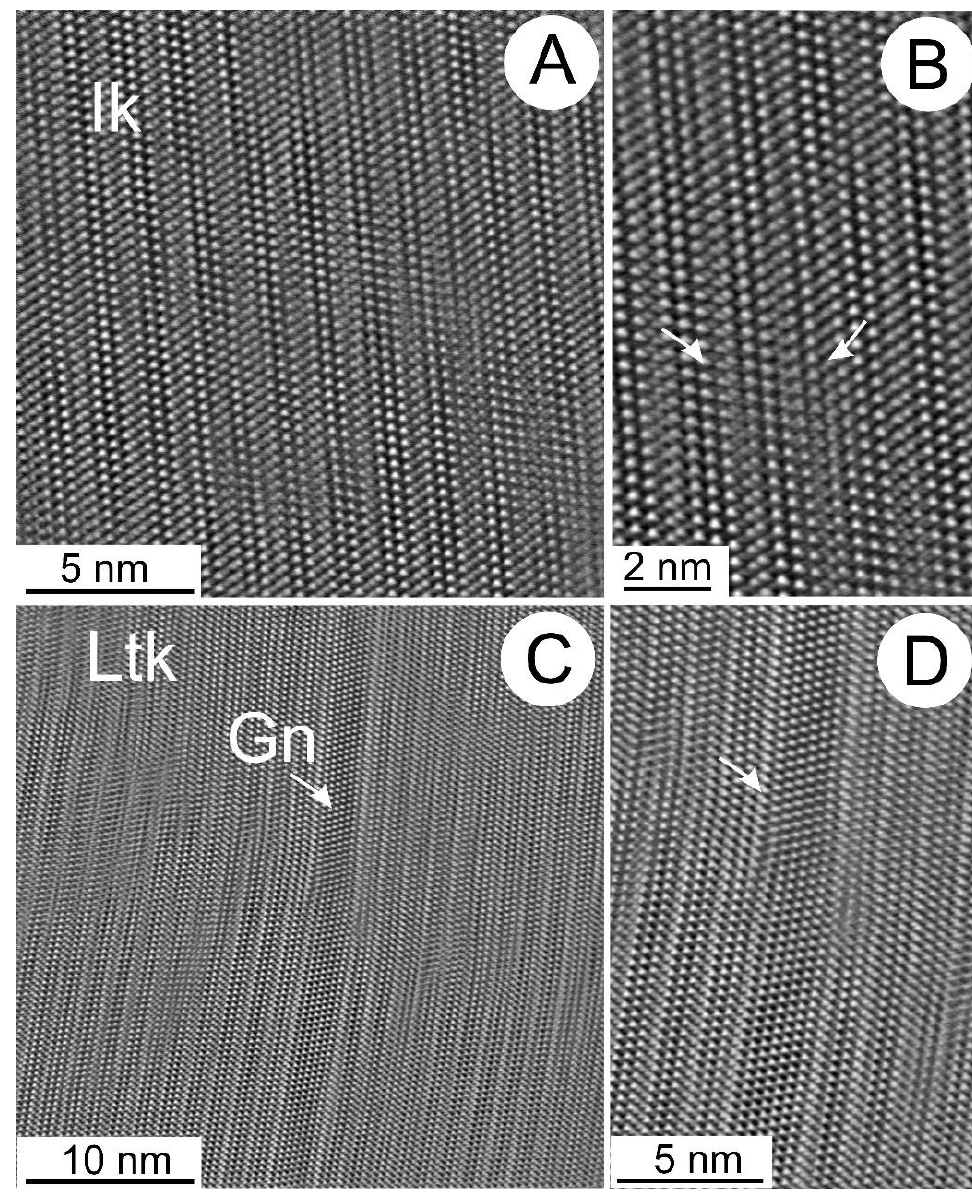
Figure 11. HAADF STEM images (obtained by DCFI procedure and filtered to eliminate noise) of ( A , B ) ikunolite (Ik) and ( C , D ) laitakarite (Ltk), showing lattice-scale defects. ( A ) Field of harmonic screw dislocations along < 011̅0 > directions in ikunolite. ( B ) Detail of (A) showing dilational swells and jogs (arrowed) along the same layers, implying screw rotation along the direction of the dislo- cation. ( C ) Screw and kink dislocations in laitakarite hosting a lamella of galena. ( D ) Detail of kink defect in galena from ( C ) showing the dislocations of atom arrays viewed on the [ 21̅1̅0 ] plane in laitakarite.